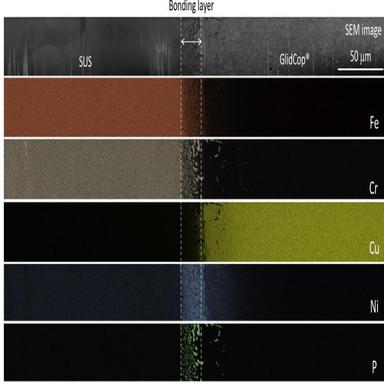
Vickers hardness (HV) distribution in the vicinity of the SUS/GlidCop® bonding interface. The 0 mm position corresponds to the bonding interface. The optical microscope image from was superimposed in the HV distribution on the same scale.